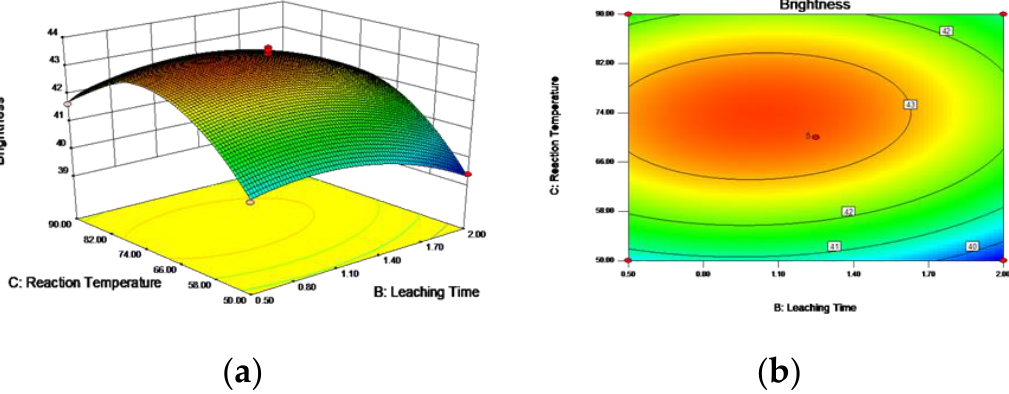
Figure 7. ( a ) The response surface plot and ( b ) the corresponding contour plot showing the effects of leaching Time and Reaction Temperature on the brightness of fly ash by removing iron-containing oxides.